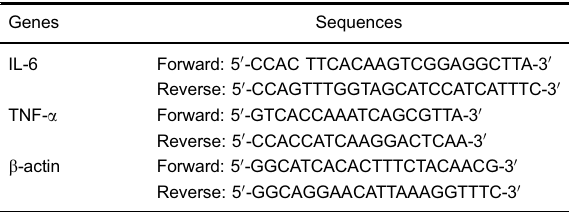
(Table 1), with b -actin acting as an internal reference. Table 1. Primer sequences of